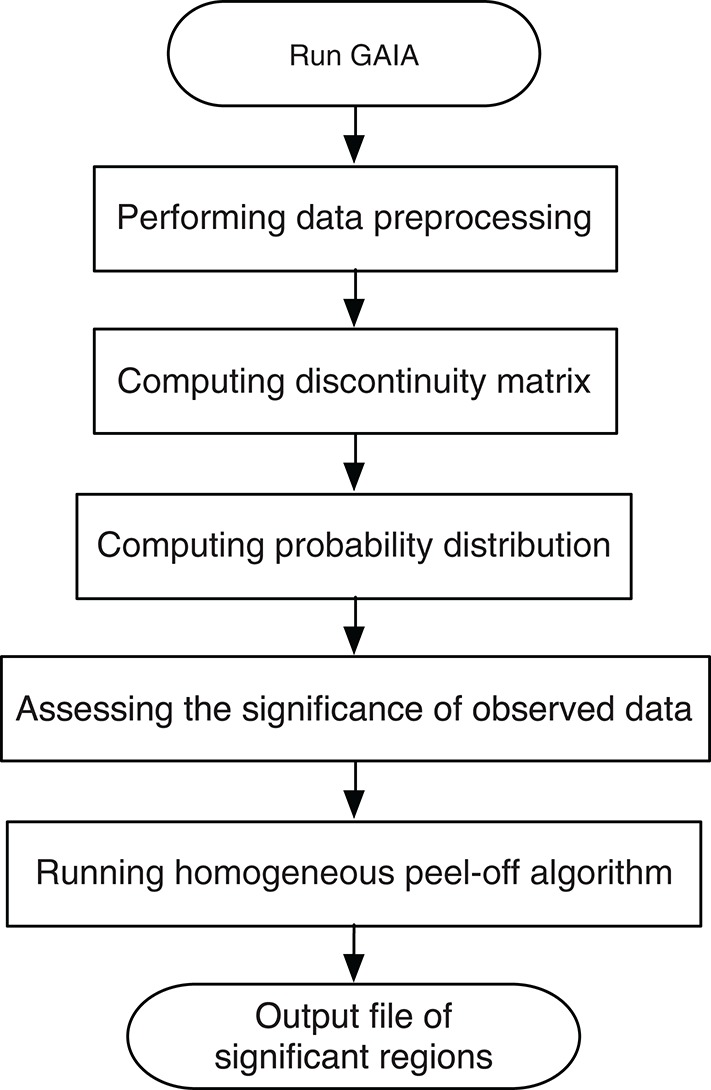
The flow chart of the GAIA method implementation steps.